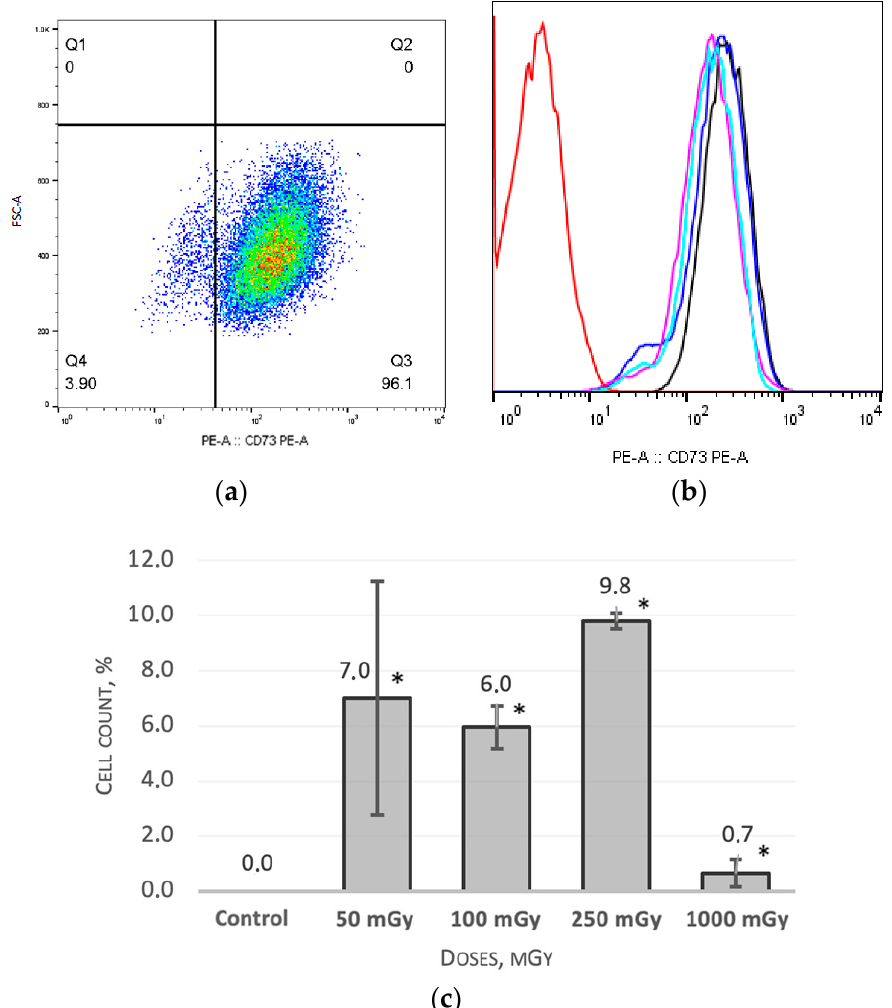
Figure 3. The CD73 expression level one of the donors MSCs 16 days after irradiation at dose of